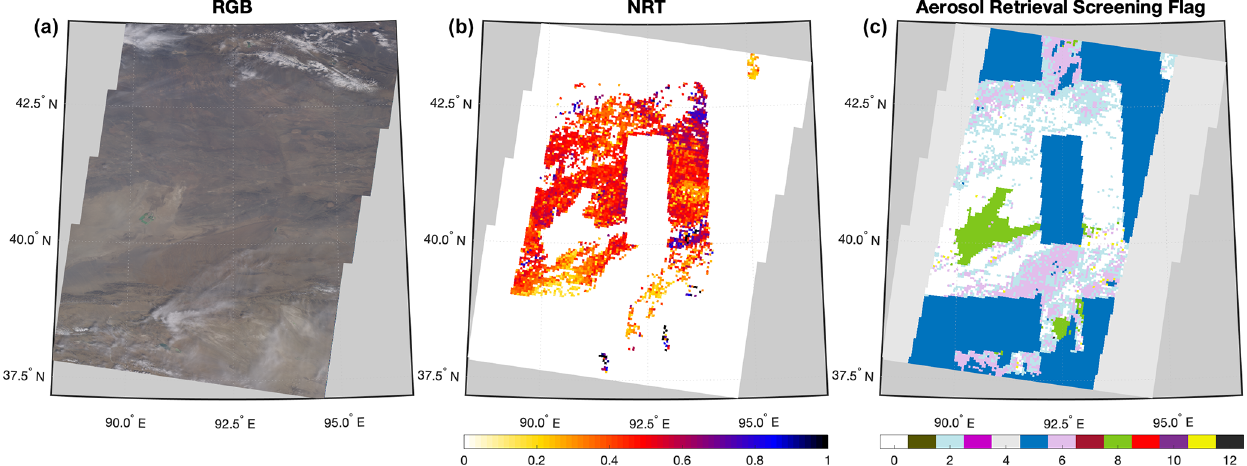
Figure 6. Example of snow or ice masking in NRT AOD retrievals. (a) Visible image of the retrieval area. (b) Corresponding NRT AOD retrievals. (c) NRT aerosol retrieval screening flag for the same area; the dark blue color denotes regions designated as cloudy.